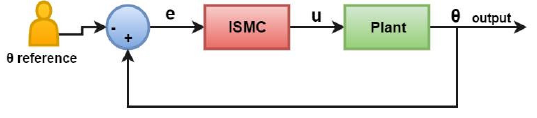
Fig. 5. The closed loop control system using